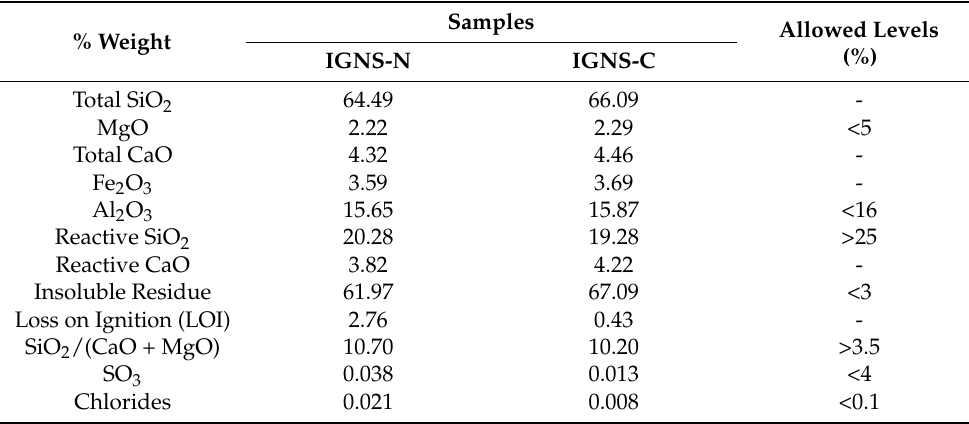
Table 2. Results of the chemical analysis of quality of the